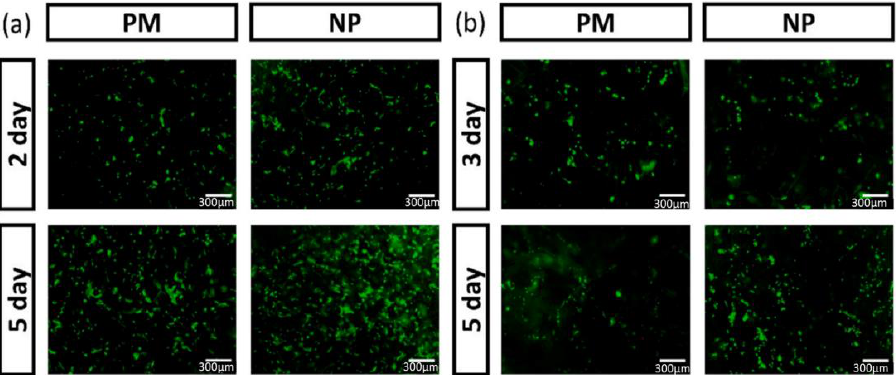
Figure 6. Viability and proliferation of the cells: ( a ) human umbilical vein endothelial cells (HU-VECs) ( b ) L929 cells in the scaffolds with and without nanoparticles. (Reproduced with permission from [53]; Copyright 2022, Elsevier).